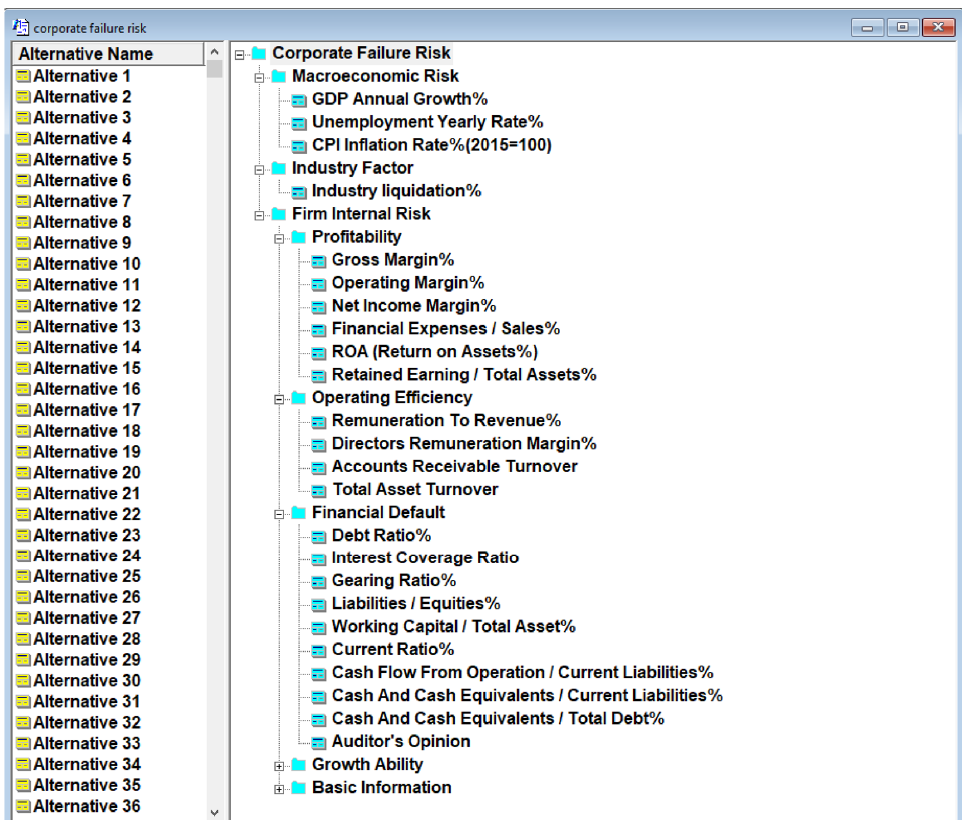
Figure 1. The hierarchical model of corporate failure risk